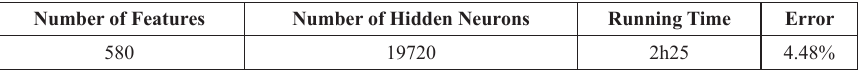
Table 2. Result of Berber-MNIST on OPIUM GPU version